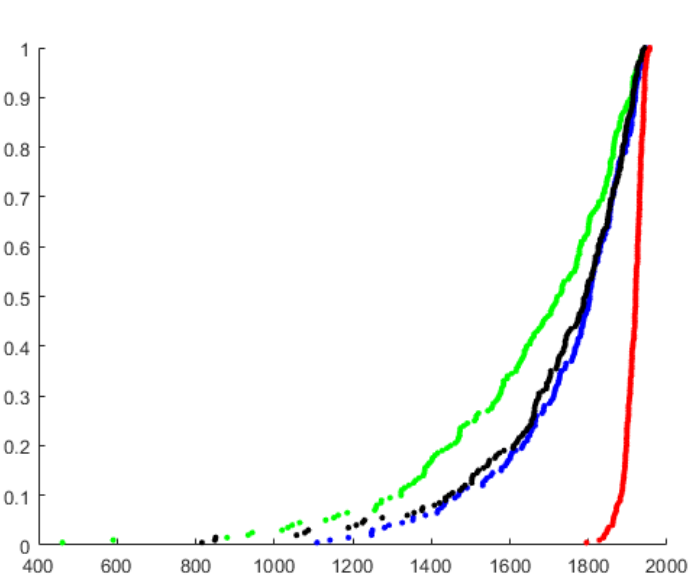
Figure 13. CDF of number of delivered packets ( λ a = 42,000). FIFO; , EDF; , Greedy; , RPS.